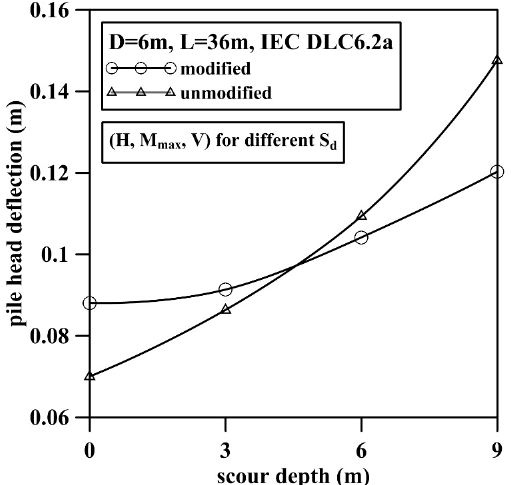
Figure 12. Relationship between the lateral displacement of the pile head on the surface before scour occurred and scour depth.